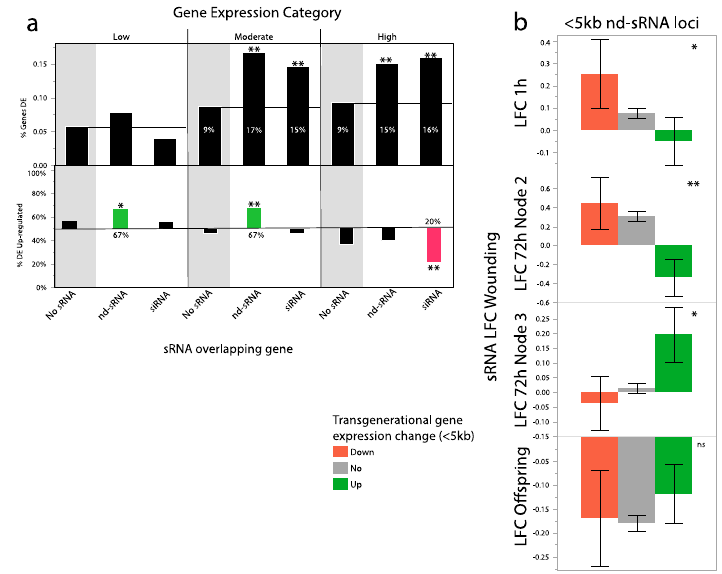
Figure 5. sRNA loci and transgenerationally differentially expressed genes. ( a ) Top: genes that overlap with sRNA loci are more likely to be differentially expressed than those that do not. Patterns of differential expression are similar for genes overlapping siRNA and nd-sRNA loci. Bottom: The direction of gene expression change varies by sRNA locus class. Lowly and moderately expressed genes that overlapped with nd-sRNA loci were more likely to be up-regulated in the progeny of wounded plants (up: 0.67, down: 0.33), while highly expressed genes that overlapped with siRNA loci were more likely to be down-regulated in the progeny of wounded plants (up: 0.20, down, 0.80). ( b ) Non-dicer sRNA plasticity to wounding tends to be negatively associated with transgenerational gene expression responses of genes near but not overlapping the sRNA loci (<5 kb). Genes that are down-regulated in the next generation tend to have increased sRNA abundance in the parents at 72 h in the wounded second leaf, while genes up-regulated in the next generation tend to have decreased sRNA abundance in the parents at the 72 h wounded second leaf. This same class of sRNAs shows similar but less extreme patterns in wounded leaf tissue at 1 h after wounding but an opposite pattern at 72 h in the unwounded 3rd leaf. ** p < 0.001, * p < 0.05.